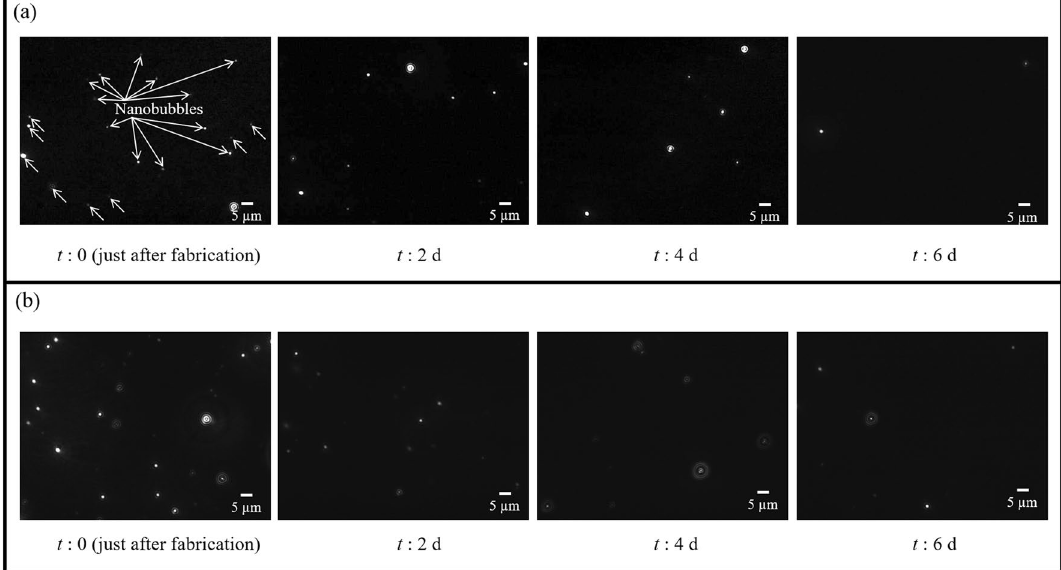
Figure 3. Images of BNBs in water over time. (a) Case 1, (b) case